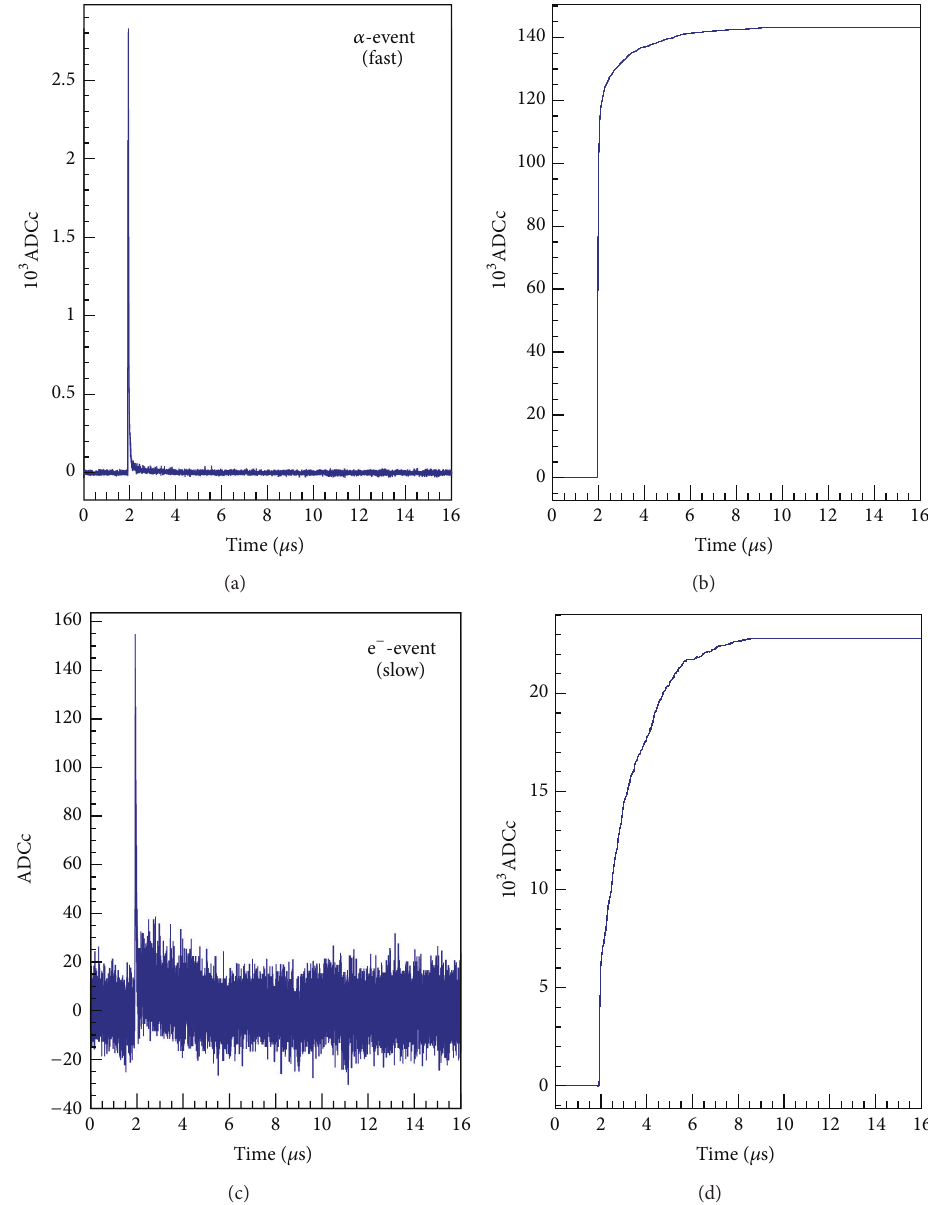
Figure 6: ((a), (b)) Total reconstructed waveform (sum of 37 PMTs, (a)) and integrated signal (b) for an 𝛼 -induced event in the inner detector. ((c), (d)) The same for an electron event. The difference in the relative weight of the fast and slow light components in the two classes of events is clearly visible in the rise times of the integrated signals, with the upper one being much smaller than the lower one (i.e., dominating fast component for the 𝛼 -particle